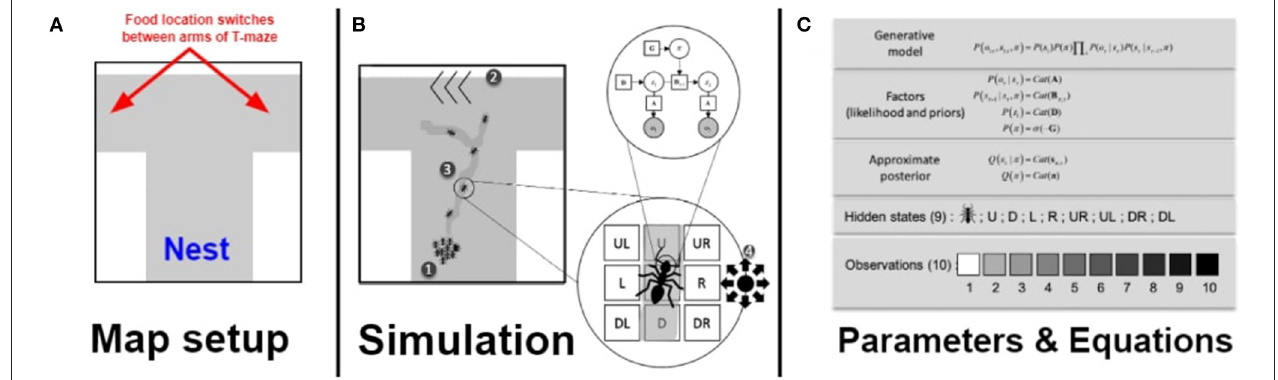
FIGURE 1 | Overview of the foraging paradigm and simulation presented in this paper. (A) In this paper we used a T-maze foraging paradigm. Foraging nestmates issue from the Nest location in blue at the bottom of the T-maze and the food switches location between the arms of the T-maze during the simulation. The gray shaded area is where ants can forage within. (B) During the simulation, described in the order of the labeling of the figure: (1) All agents (simulated ants) start at the same nest location. (2) Their task is to reach a food resource on the map, which is on one arm of a T-maze. (3) While unladen (e.g., heading out on a foraging trip), the ant does not deposit pheromone, and moves toward locally increased density of pheromone. After encountering the food, the ant leaves a pheromone trail on its way back toward the nest, again moving toward locally increased density of pheromone. (4) Crucially, ants only have sensory access to their immediate surroundings and do not know where the food resource is located on the map. All they can sense is what surrounds them immediately and its current location, as well as outcomes associated with each of these states. (C) Expanded table of Parameters and Equations. For each ant, at each time step, there are 10 possible observations, which correspond to 10 levels of pheromone density (which range from 1 to 10). Each ant can select policies that transition between surrounding locations (which are modeled as hidden states that the agent has to infer based on sensory cues). This means that the generative model of each ant is made of a likelihood and a prior that are limited to the representations of these nine locations. The policies available to the ant correspond to transitions from the current location to one of nine possible locations (i.e., same location, up, right, down, left, top-left, top-right, bottom-left, and bottom-right), and evolves over one time step. (5) The environment in which the ant navigates is a 40 40 matrix, with each location corresponding to an index from 1 to 1,600 that allows us to respecify the likelihood matrix of the ant after each step (see Appendix ). × Each location in the environment generates a given outcome, which can change based on whether the ant passed over that location and left a pheromone trail. There is no modulation of the likelihood precision in our simulation, which means that each ant always has an unbiased sensory access to its